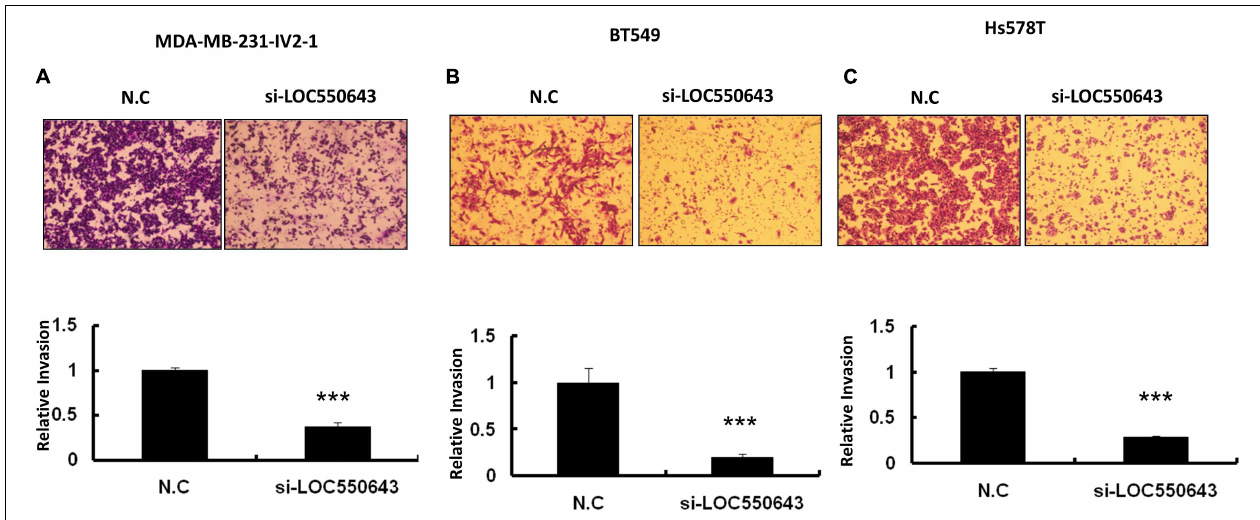
FIGURE 6 | Significant suppression of breast cancer cell invasion ability through LOC550643 knockdown. (A–C) Invasion assay conducted with MDA-MB-231-IV2-1, BT549, and Hs578T with and without LOC550643 knockdown. The representative images of invading cells stained with crystal violet solution (upper panels). Three different fields were subjected to count numbers of invading cells. The related invasion capability was evaluated using the number of invading cells of LOC550643 knockdown as compared with the control (means ± SD) (lower panels). All experiments were carried out in triplicate. Using Student’s t -test to analyze our data and p < 0.05 was considered significant (* p < 0.05, ** p < 0.01, and *** p <